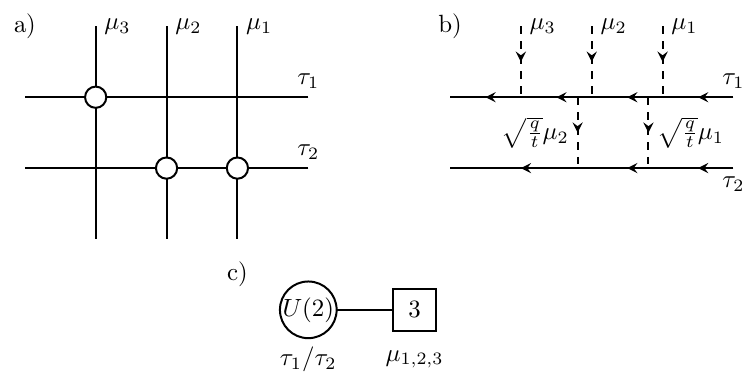
Figure 1 . Comparison of two different formalisms for building a 3 d N = 2 ∗ quiver gauge theory. a) The old formalism: horizontal and vertical solid lines denote horizontal and vertical Fock repre- sentations respectively; circles and crossings denote resolved conifold-like geometries with specially tuned parameters. The notation is explained in detail in [42, 43]. b) The new formalism. Solid horizontal lines still denote horizontal Fock spaces, while vertical dashed lines are vertical vector representations. They are joined together by Higgsed vertices. Notice how each circle in a) gives rise to dashed line emanating upwards from the corresponding point in b). Individual dashed lines correspond to screening charges acting on the Fock spaces represented by solid lines, so that the overall picture gives a Dotsenko-Fateev-like integral representation of the holomorphic block. c) The quiver gauge theory modelled by a) and